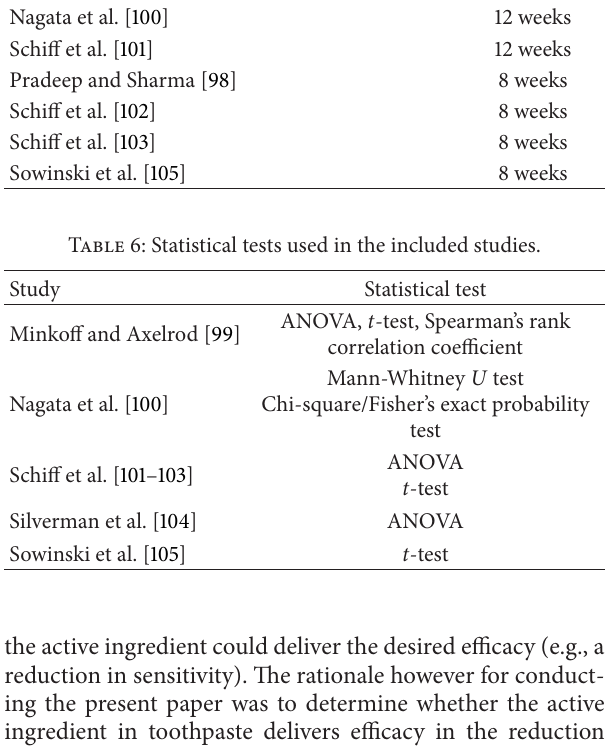
Product withdrawn from the market.